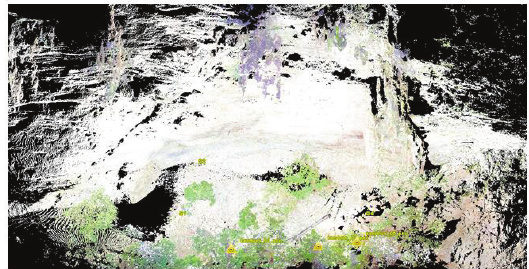
Figure 10: The plan view of the terrestrial laser scanning data (for Tambun Cave)